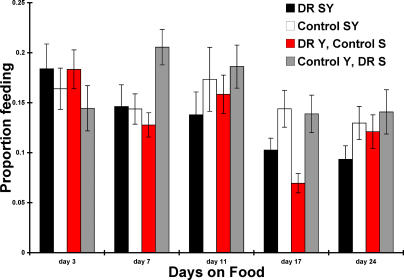
Feeding Rates of Female Drosophila on Food Media with Different Nutrient ConcentrationsFeeding rates were recorded by direct observation as the proportion of time flies spent on the surface of the media with their proboscis extended and touching the food (y-axis). Replicate measurements of the proportion of females feeding versus those not feeding were recorded during a 2-h period on the days shown. No significant different was seen between flies fed different diets on days 3, 7, 11, and 24 as assessed by chi-squared tests (p > 0.01, Bonferroni correction for multiple comparisons). There was a significant difference in feeding rates on day 17 (p = 0.0068) with flies on the DR yeast/control sugar media eating less. These data show that Drosophila does not exhibit compensatory feeding behaviour for the DR regime imposed.